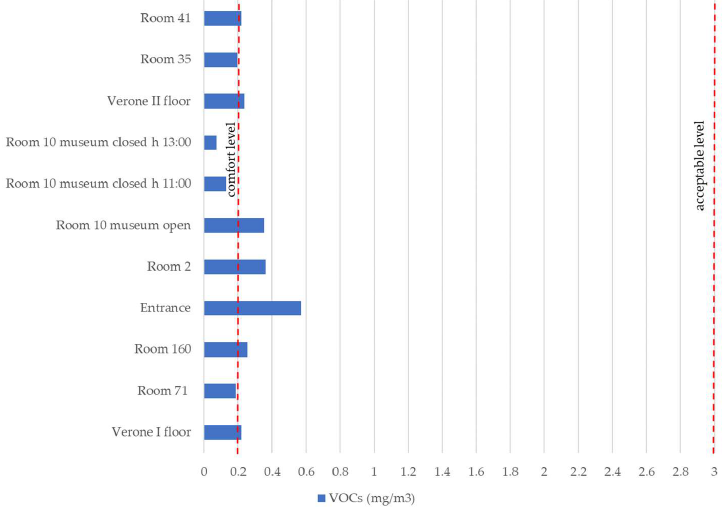
Figure 8. Sampled values for VOCs (mg/m 3 ) in the analyzed rooms of the Uffizi Gallery compared with comfort (<0.200 mg/m 3 ) and acceptable (0.200 ÷ 3 mg/m 3 ) values for people.